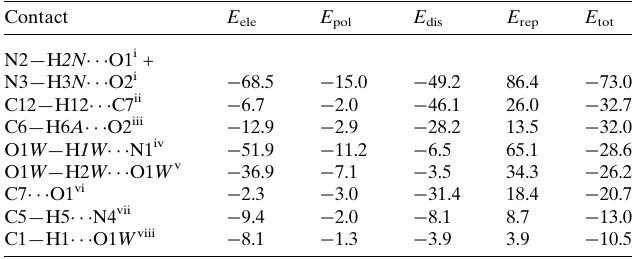
Table 3 Summary of interaction energies (kJ mol (cid:5) 1 ) calculated for (I). Contact E ele E